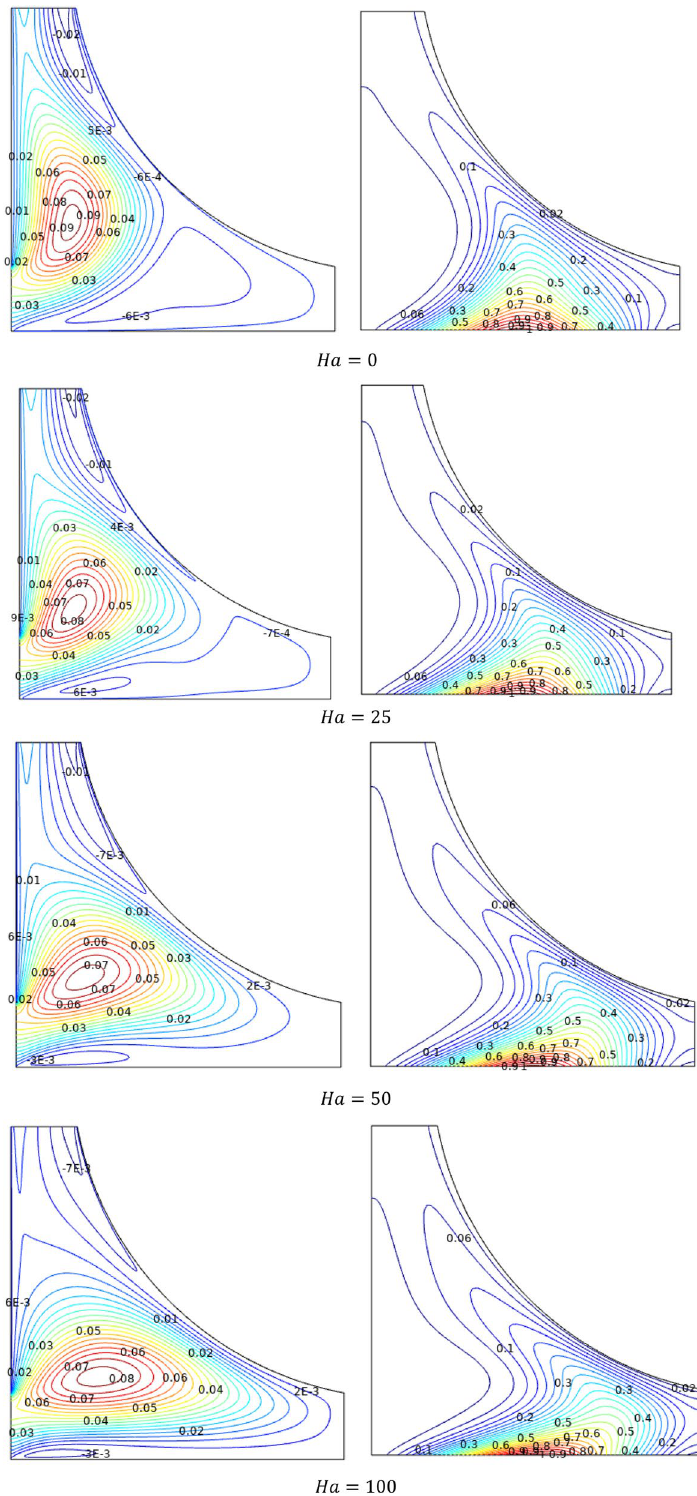
Figure 11. Variations of the streamlines ( (cid:31) ) and isotherms ( T ) with various Ha at configuration 1, Re = 200 , Ri = 1 , ϕ = 0.02